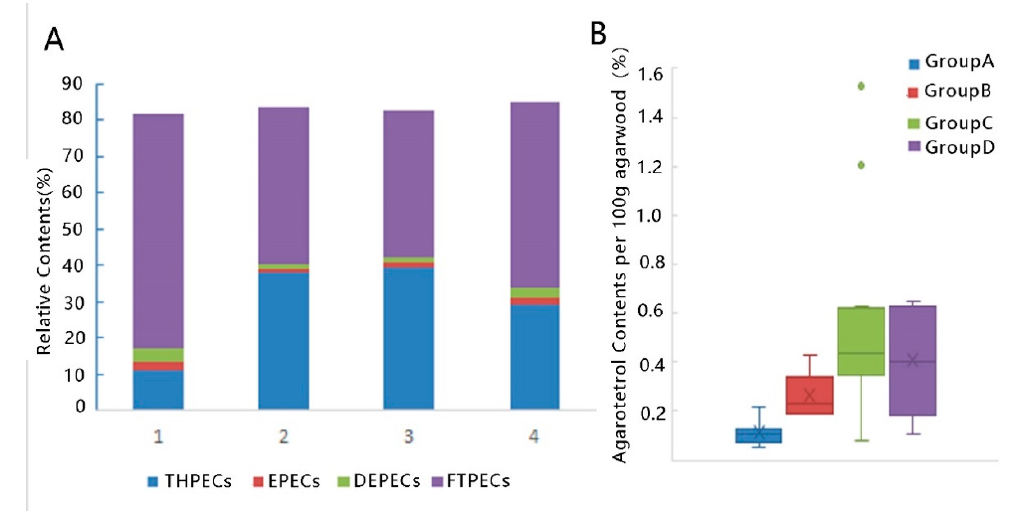
Figure 4. Contents of PECs in artificial agarwood groups. ( A ). Percentiles of four types of PECs in four artificial agarwood group. ( B ). Contents of agarotetrol (g/100 g) in artificial agarwood groups. group A, wounding by axe; group B, burning-chisel-drilling; group C, chemical inducers; group D, biological inocula.